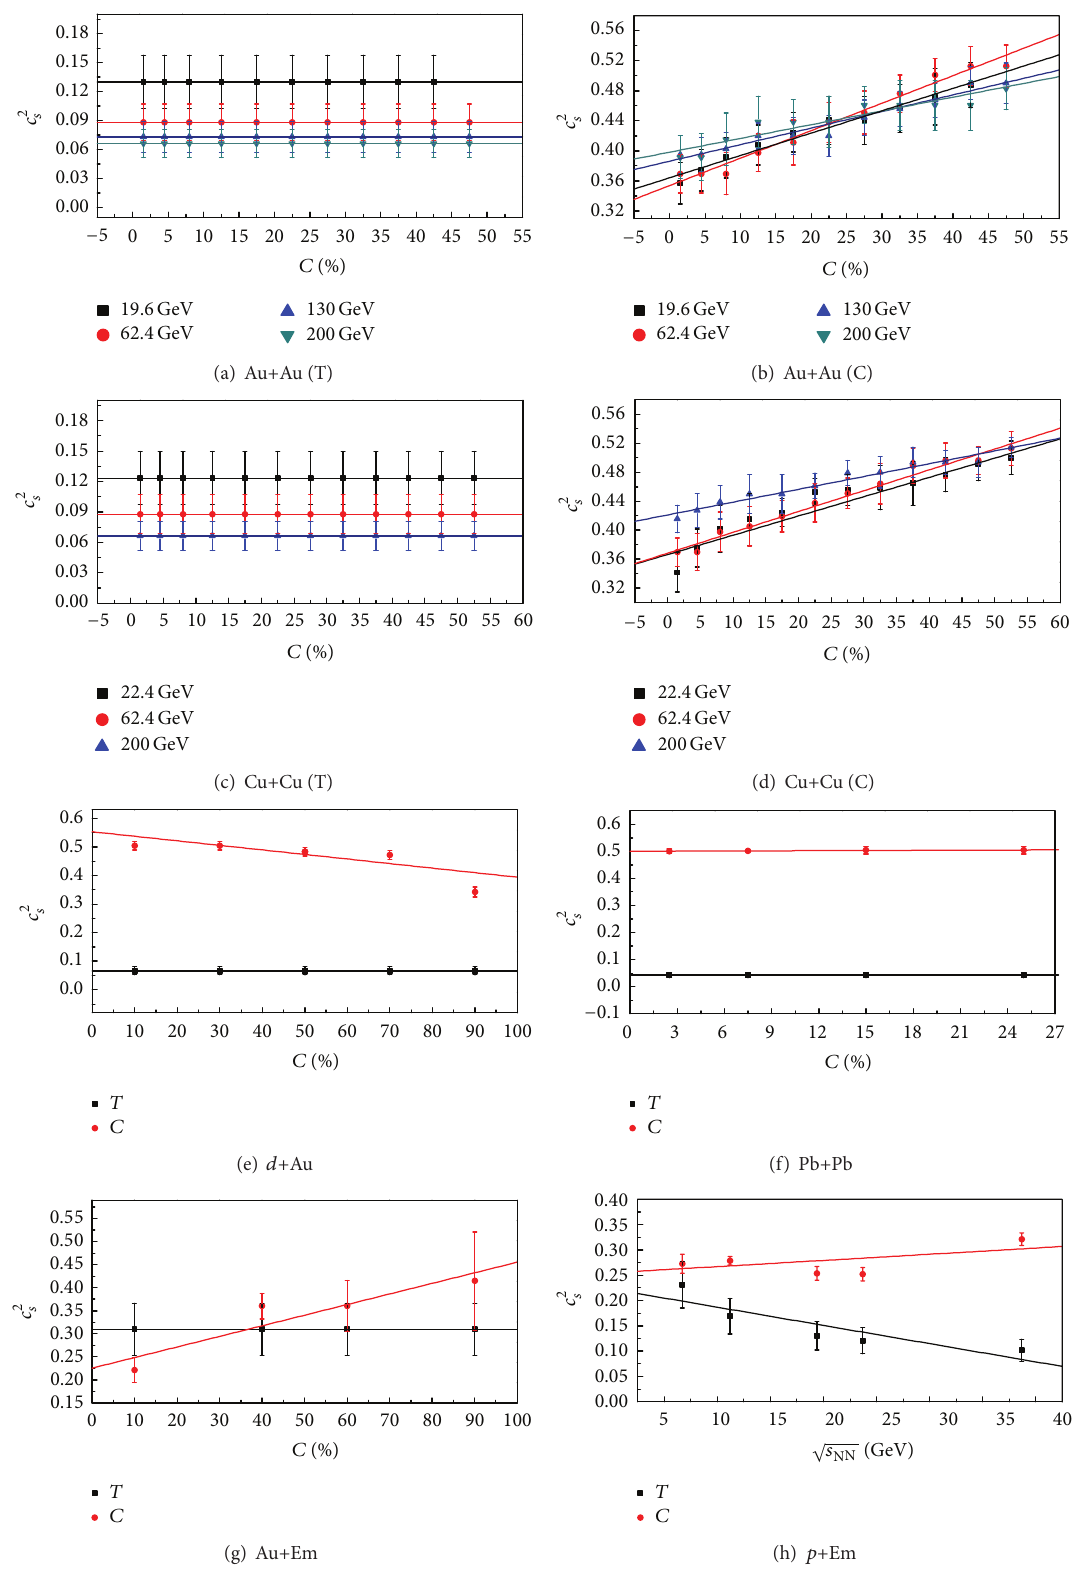
Figure 14: Dependences of 𝑐 2 𝑠 for target (T or projectile (P)) and central sources (C) in Au-Au, Cu-Cu, 𝑑 -Au, Pb-Pb, Au-Em, and 𝑝 -Em collisions on 𝐶 or √𝑠 NN . The symbols are quoted in Tables 1–6, and the lines are our fitted